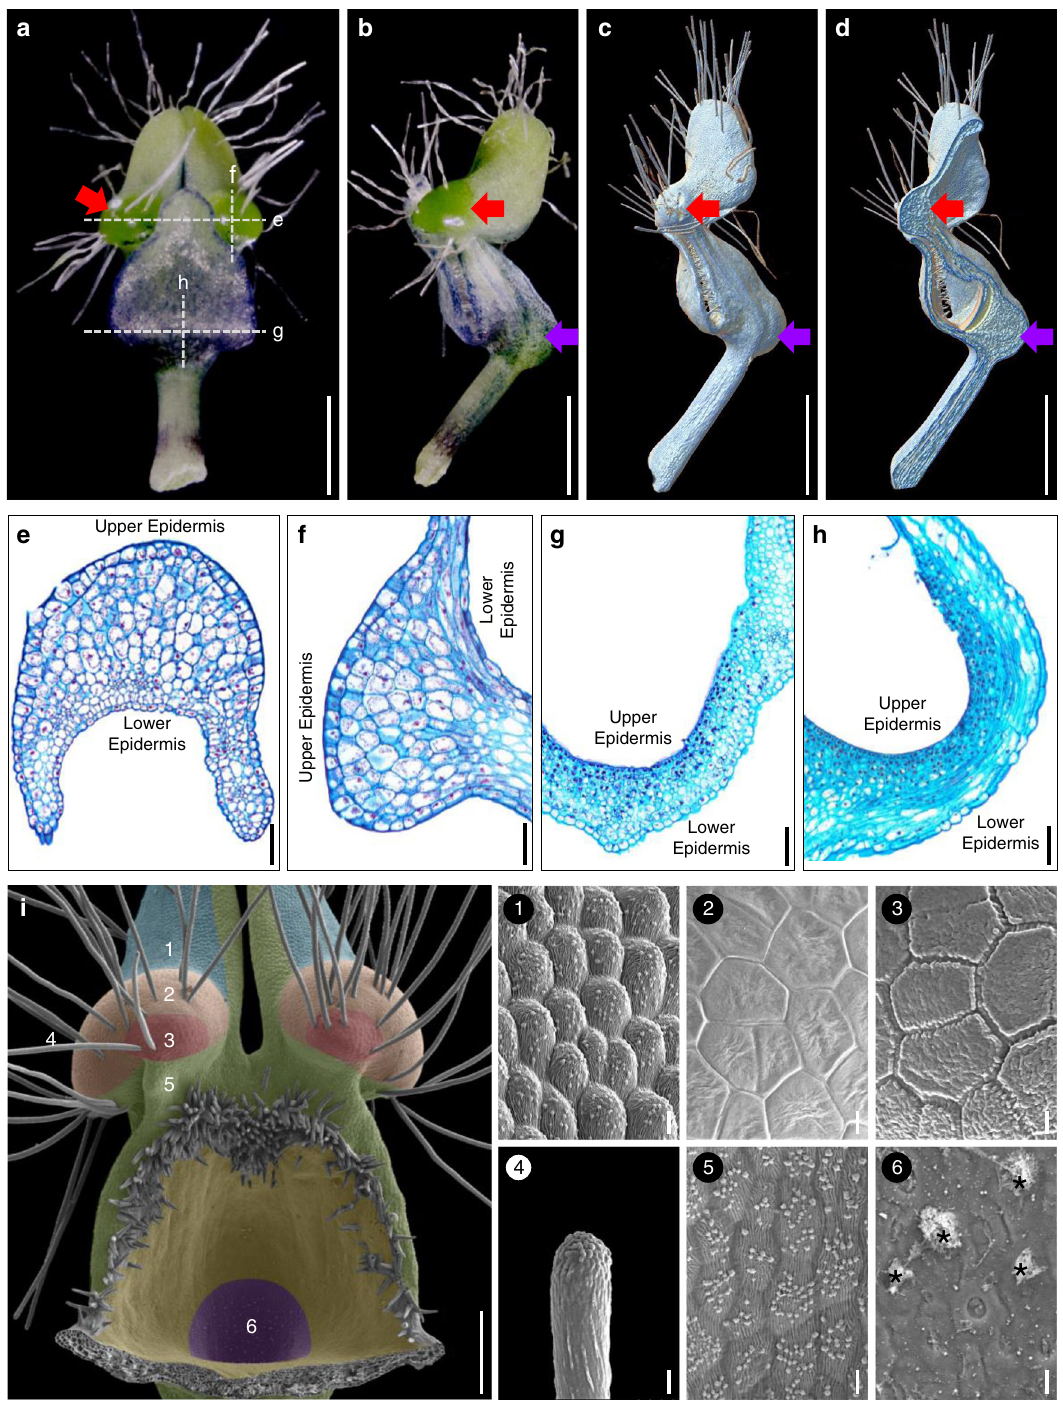
Fig. 2 The pseudonectary morphology. Mature petals under stereomicroscope: adaxial ( a ) and lateral ( b ) views. c – d Mature petals under micro-CT. Red and purple arrows in a – d point to the pseudonectary and the nectary, respectively. Scale bars: 1 mm. Anatomy of the pseudonectary and nectary: transverse ( e , g ) and longitudinal ( f , h ) sections. Scale bars: 100 μ m. i Micromorphology of the pseudonectary. The numbered regions (1 – 6) in different colors represent the distribution of different types of epidermal cells. Asterisks in (6) indicate residual nectar. Scale bars: i , 100 μ m; 1 – 6, 10 μ m. For a – i and 1 – 6, the experiments were repeated three times independently with similar (Fig. 5f, j). When sectioned, the number and size of the cells in the pseudonectary regions decreased dramatically, whereas the number of cells in the lobe regions were largely not affected (Fig. 5g, k – m). This con fi rms that NidaYAB5 plays key roles in pseudonectary development.